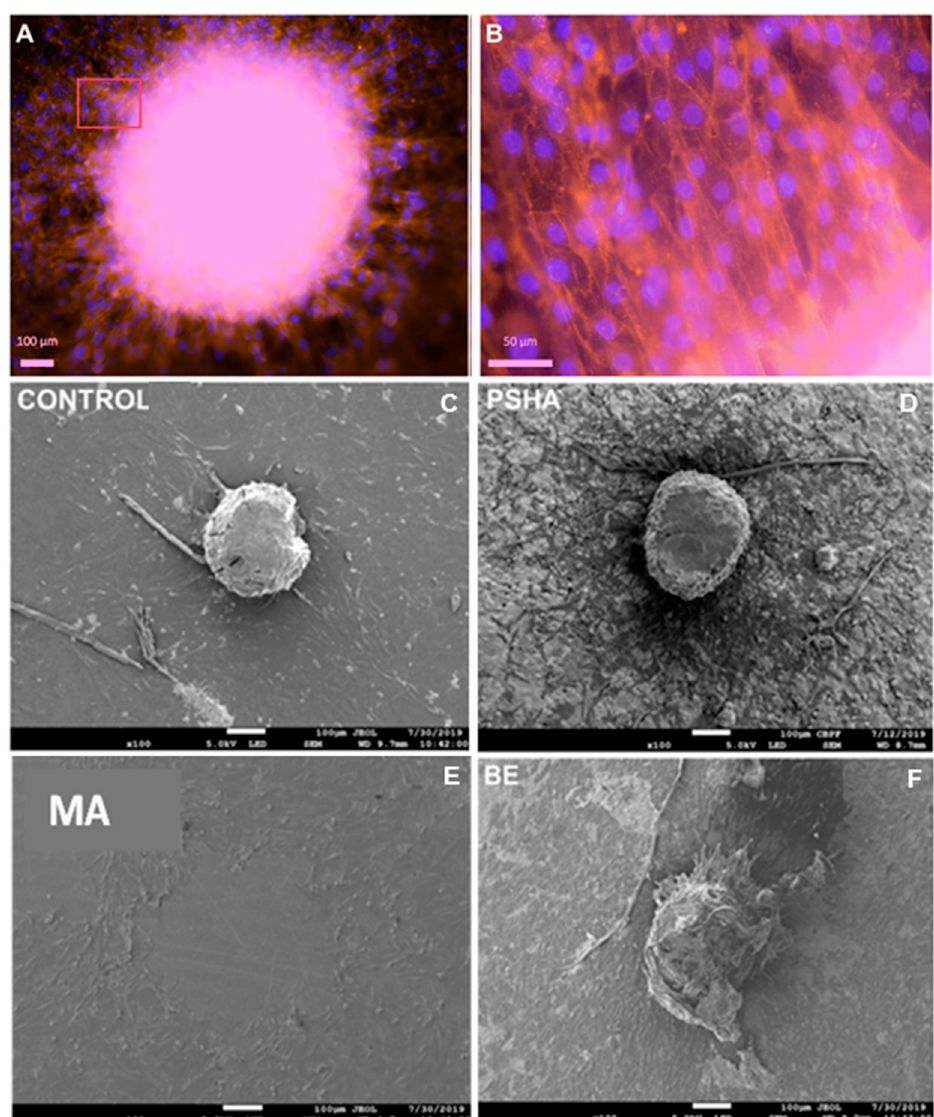
Figure 4. Images of the interaction of the osteospheres with the different material surfaces by fluorescence microscopy ( A , B ) and scanning electron microscopy ( C – F ). Cells migrating and adhering to the control surface (Thermanox) at 20 × magnification ( A ). The region indicated by the red quadrant is shown at higher magnification in ( B ). The cells have the cytoskeleton stained with phalloidin in red and the nucleus marked with DAPI in blue. Panels C to F show SEM micrographs of aggregates adhered to the control and titanium surfaces with 5 days of exposure. A pattern of cells can be seen leaving the aggregates and covering the material surfaces, even when the aggregate was unattached during sample processing